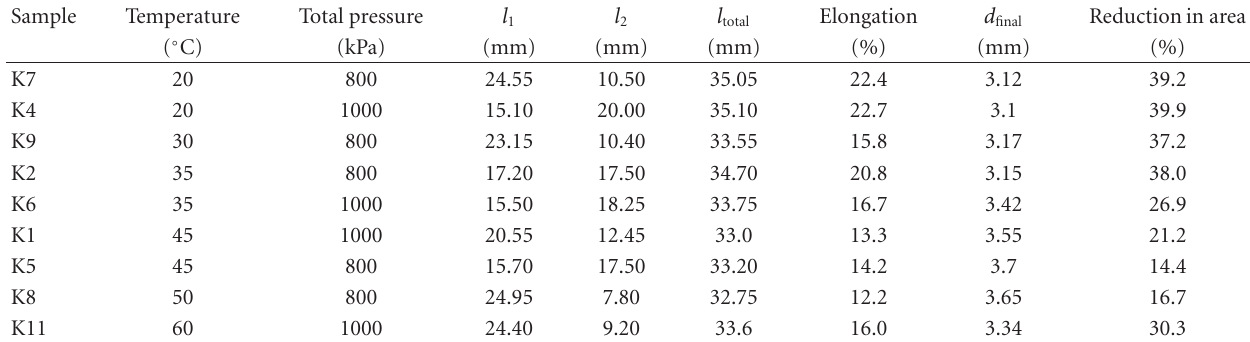
Table 3: Temperature-dependent results of samples machined perpendicular to the rolling direction.